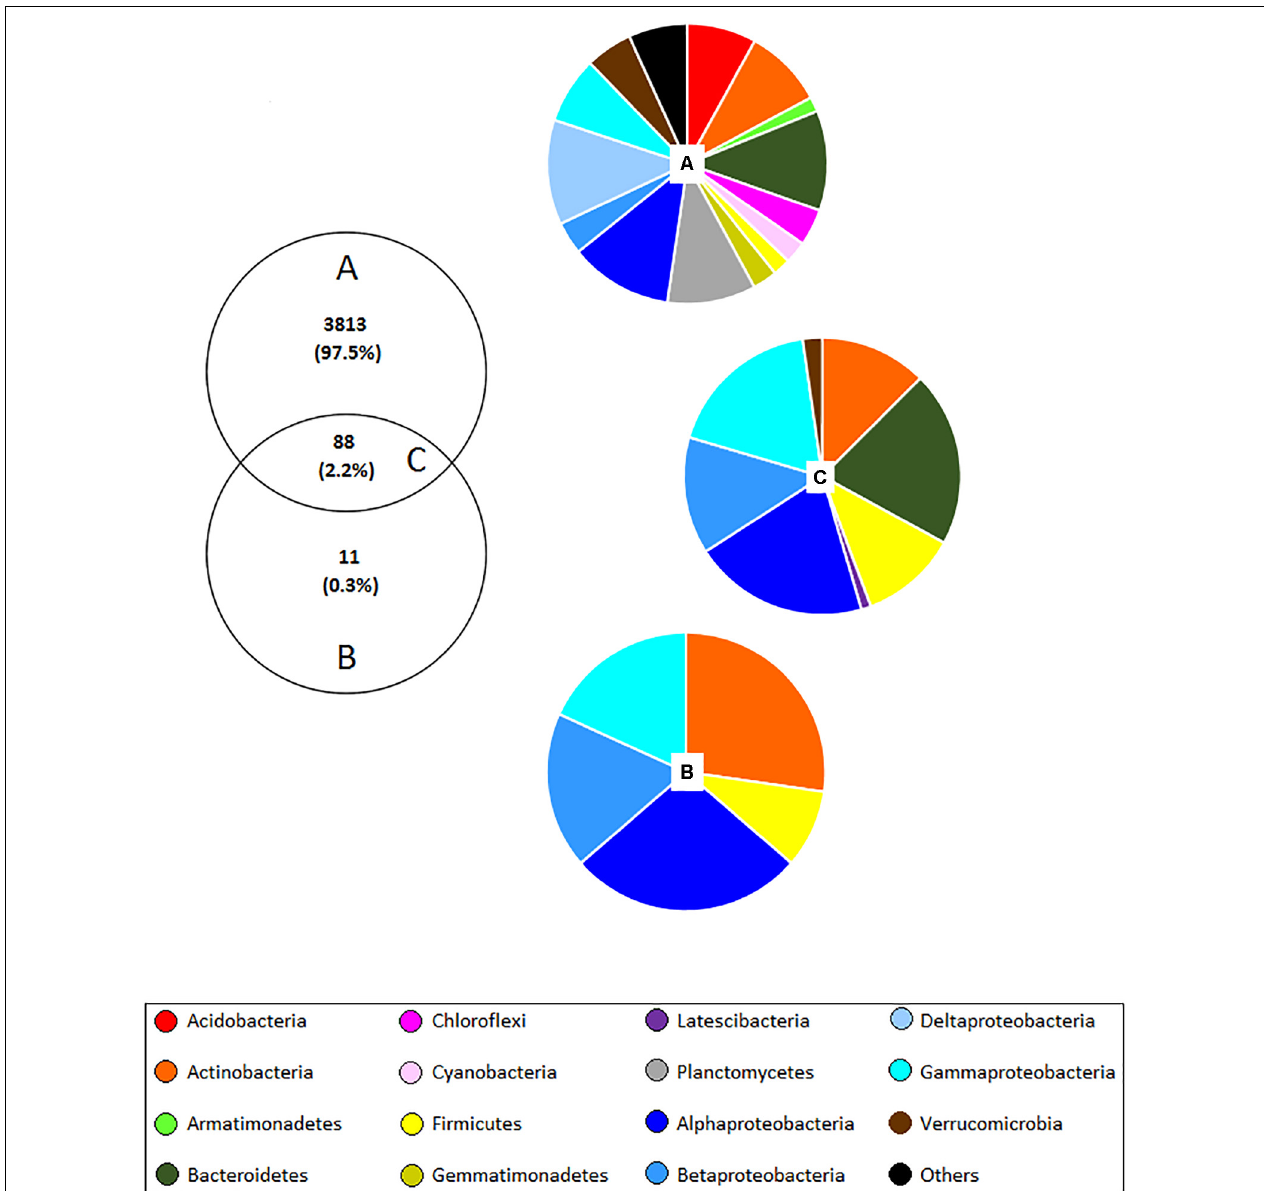
FIGURE 3 | Venn diagram showing the number and proportion of shared OTUs (C) (at 97% similarity) detected with both unculturable (A) and culturable (B) methods in the wheat rhizosphere. Pie charts correspond to the percentage of bacterial phyla and classes of Proteobacteria assigned to each OTU. “Others” include 26 phyla corresponding to < 1%, which include: BJ-169, BRC1, Candidatus Berkelbacteria, Chlamydiae, Chlorobi, Deinococcus–Thermus, Elusimicrobia, FBP, FCPU, Fibrobacteres, Gracilibacteria, Ignavibacteriae, Latescibacteria, Microgenomates, Nitrospirae, Omnitrophica, Parcubacteria,